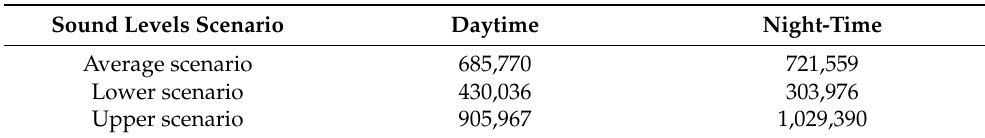
Table 1. Number of people in metropolitan France exposed to WT sound levels above 30 dBA for daytime and night-time propagation conditions. The lower/upper scenarii correspond to +/ − 1 standard deviation on the Harmonoise sound level estimate.